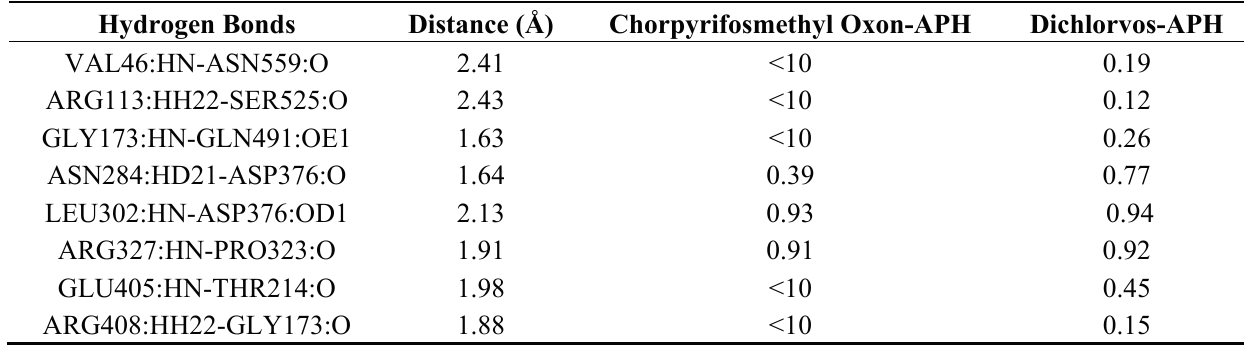
Table 2. Hydrogen bonds occupancies for the α / β hydrolase fold domain and β -propeller domain with chorpyrifosmethyl oxon and dichlorvos bound APH during MD simulations. Hydrogen Bonds Distance (Å) Chorpyrifosmethyl Oxon-APH